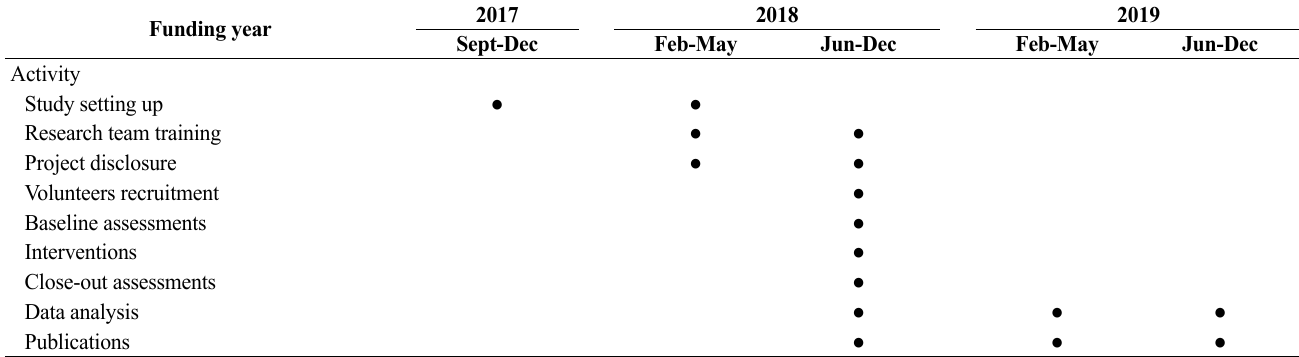
Table 3. Provisional calendar for the REI